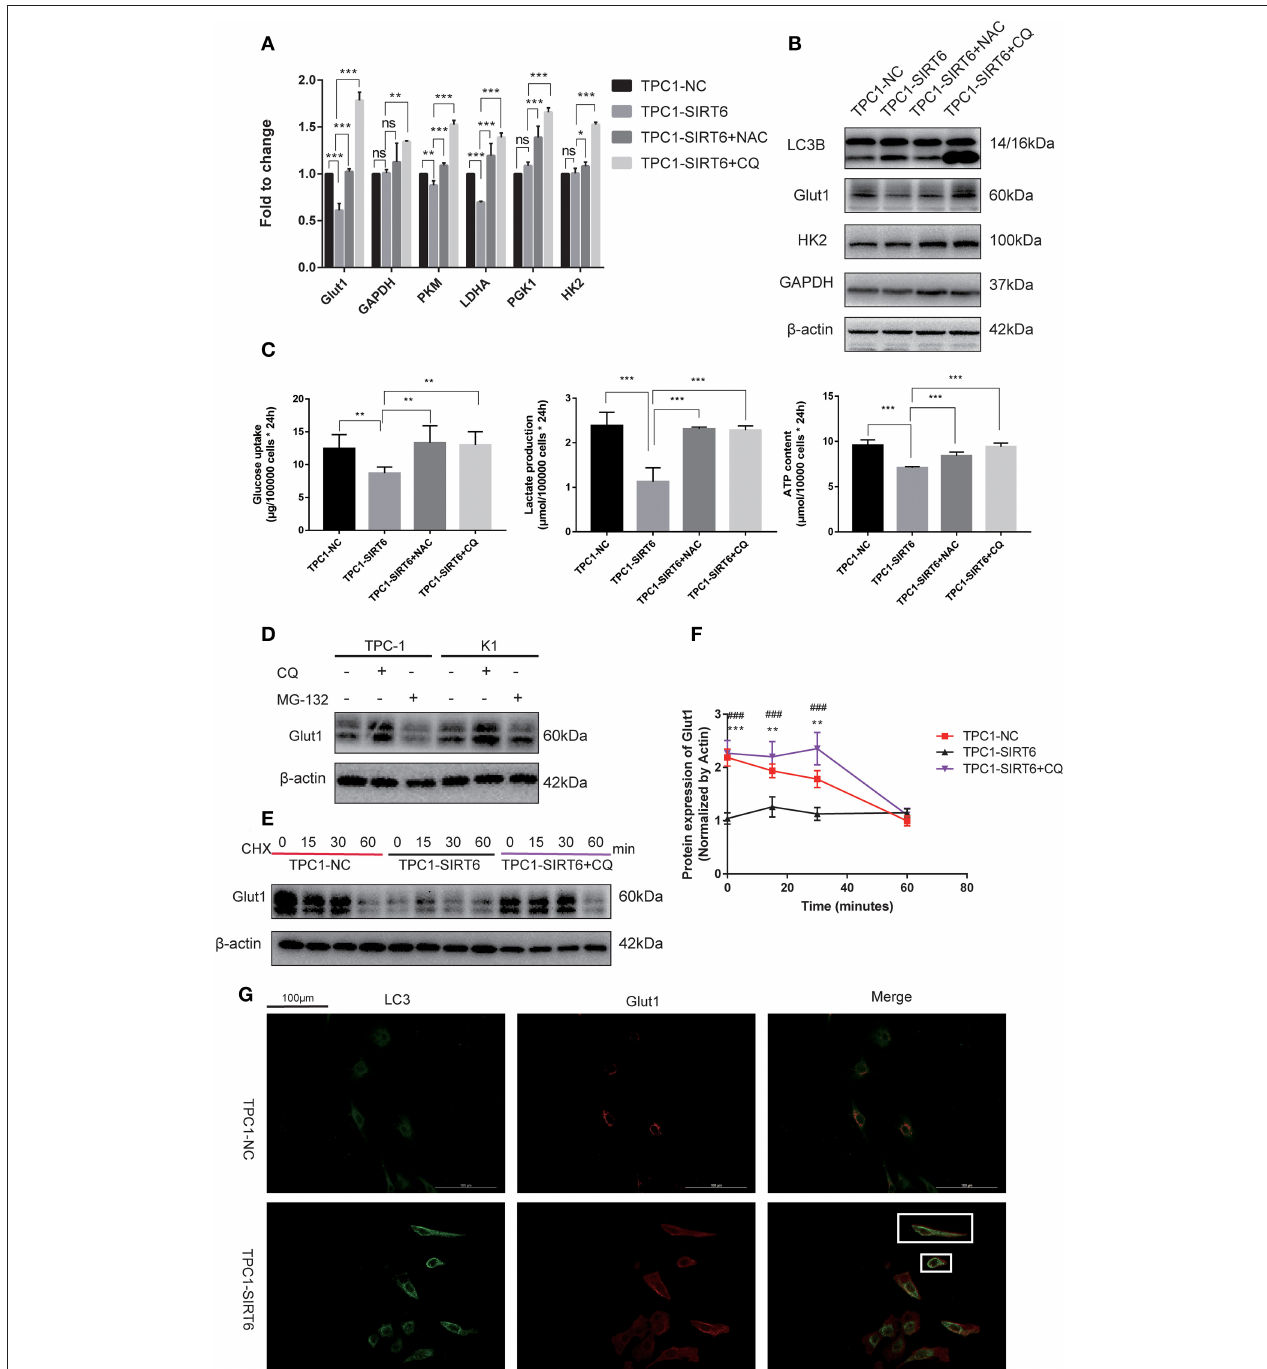
FIGURE 3 | SIRT6 inhibited the Warburg effect by inducing the autophagic degradation of GLUT1. (A) The mRNA expression of Warburg effect-associated genes (GLUT1, GAPDH, PKM, LDHA, PGK1, and HK2) in TPC1-NC, TPC1-SIRT6, and TPC1-SIRT6 cells treated with CQ and NAC. (B) Levels of proteins involved in the Warburg effect (GLUT1, HK2, and GAPDH) in TPC1-NC, TPC1-SIRT6, and TPC1-SIRT6 cells treated with CQ and NAC. (C) Glucose uptake, lactate production and ATP concentrations in TPC1-NC, TPC1-SIRT6, and TPC1-SIRT6 cells treated with CQ and NAC (* p < 0.05, ** p < 0.01, and *** p < 0.001). (D) Levels of the GLUT1 proteins in TPC-1 and K1 cells treated with CQ and the proteinase inhibitor MG-132 (10 µ M for 6h). (E,F) Levels of the GLUT1 protein at different time points (0, 15, 30, and 60min) after the withdrawal of the 24-h CHX treatment in TPC1-NC, TPC1-SIRT6, and TPC1-SIRT6 cells treated with CQ (*TPC1-NC vs. TPC1-SIRT6, ** p < 0.01 and *** p < 0.001; #TPC1-SIRT6 vs. TPC1-SIRT6 + CQ, ### p < 0.001). (G) Images of immunofluorescence staining for GLUT1 and LC3 in TPC1-NC and TPC1-SIRT6 cells.